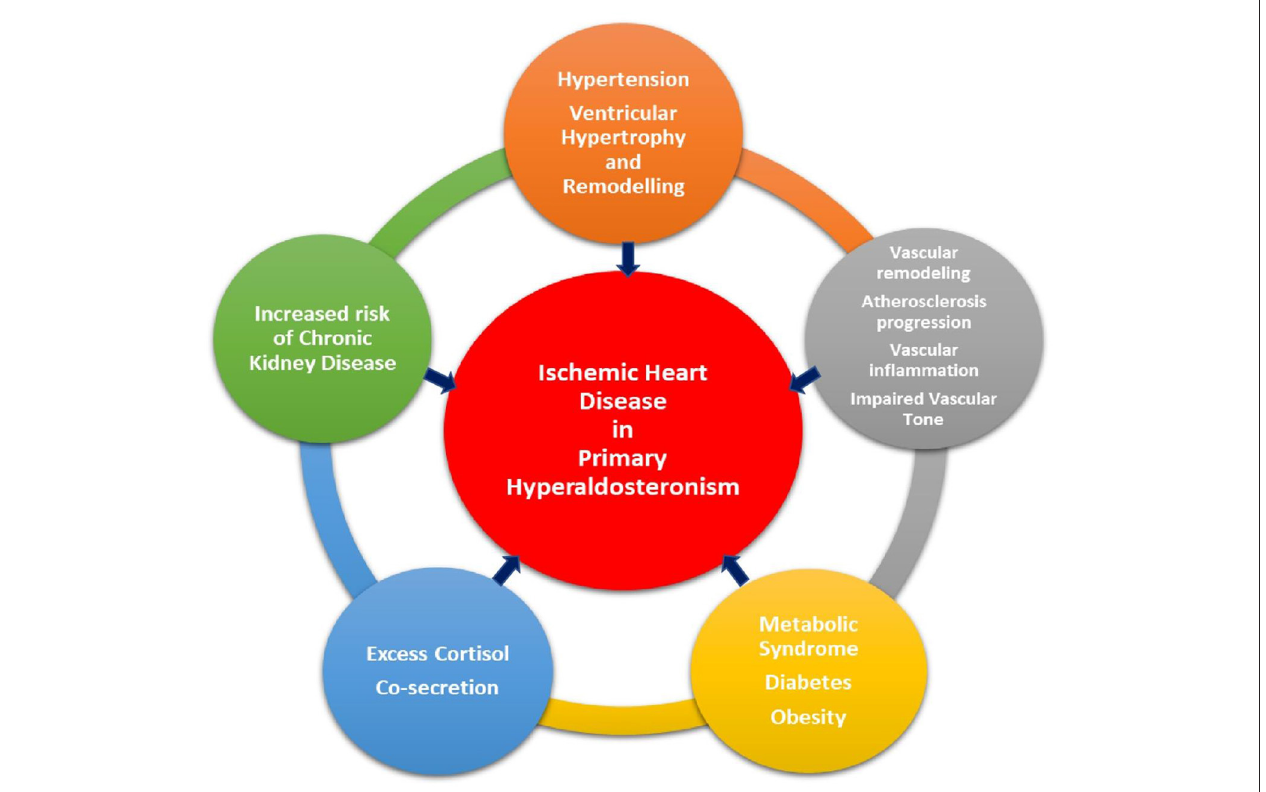
FIGURE 1 | Pathways through which primary aldosteronism plays a role in the development of ischemic heart disease.